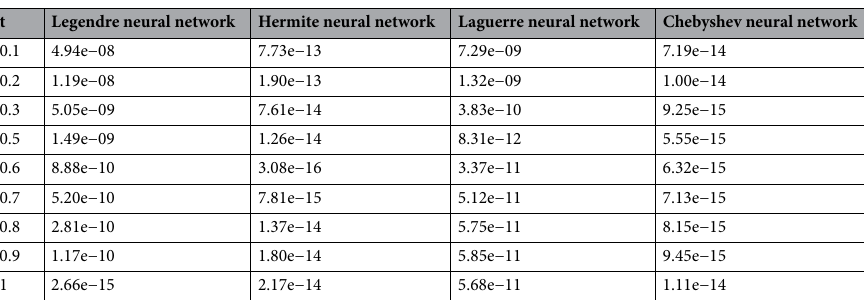
Table 4. The relative error for Example 6.2 with different orthogonal neural